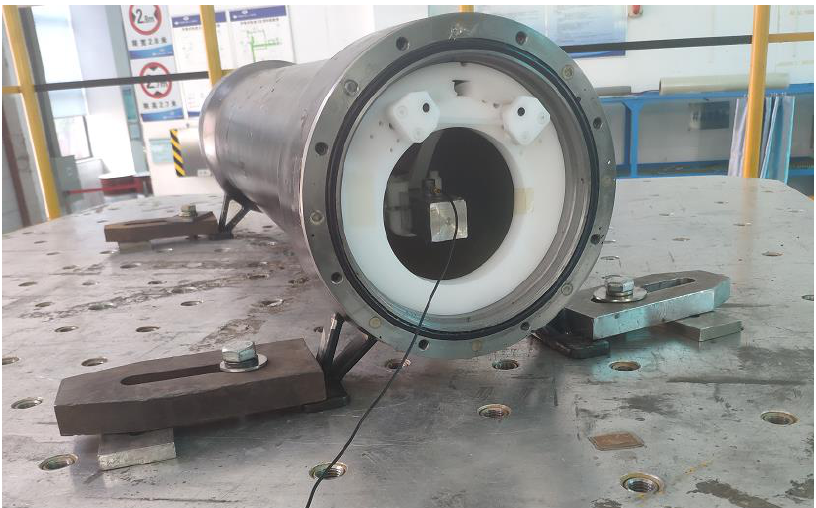
Figure 9. Installation diagram of the magnetic antenna on the vibrating table.